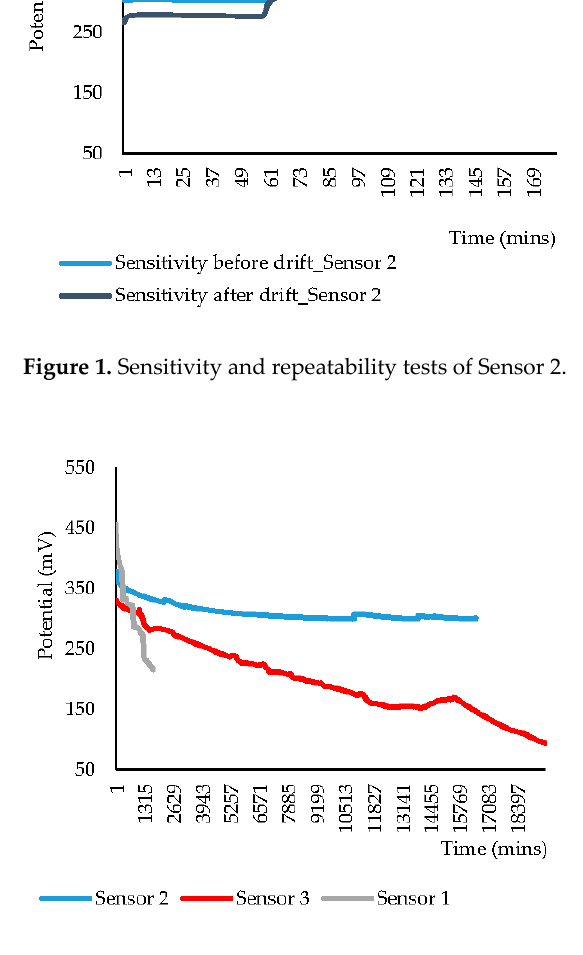
Figure 2. Drift test of Sensors 1, 2, 3 with layer barrier. Table 3. Sensitivity and repeatability tests’